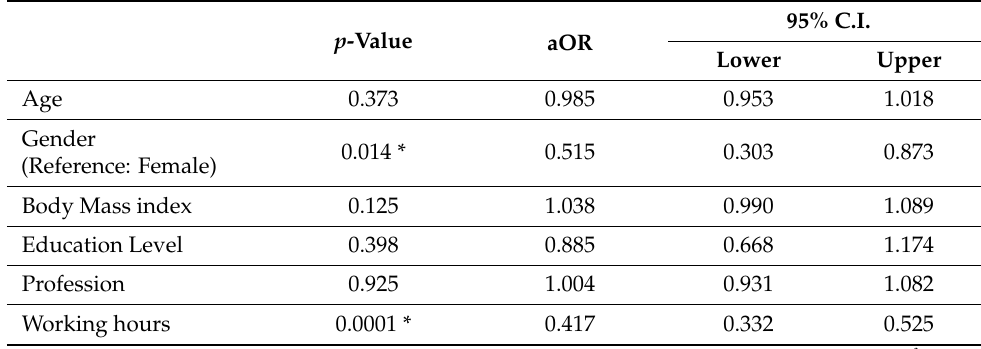
Table 4. Regression analysis to ascertain the effects of age, gender, level of education, profession, and working hours on the likelihood of having neck pain during last twelve months &